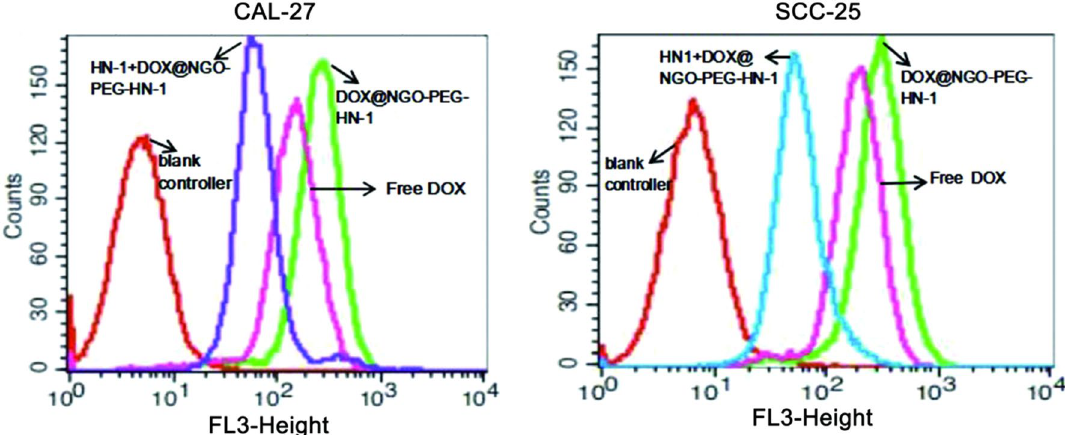
Figure 9. CAL-27 and SCC-25 cell uptake ration of DOX when incubated with DOX@NGO-PEG-HN-1, free DOX or HN-1 +